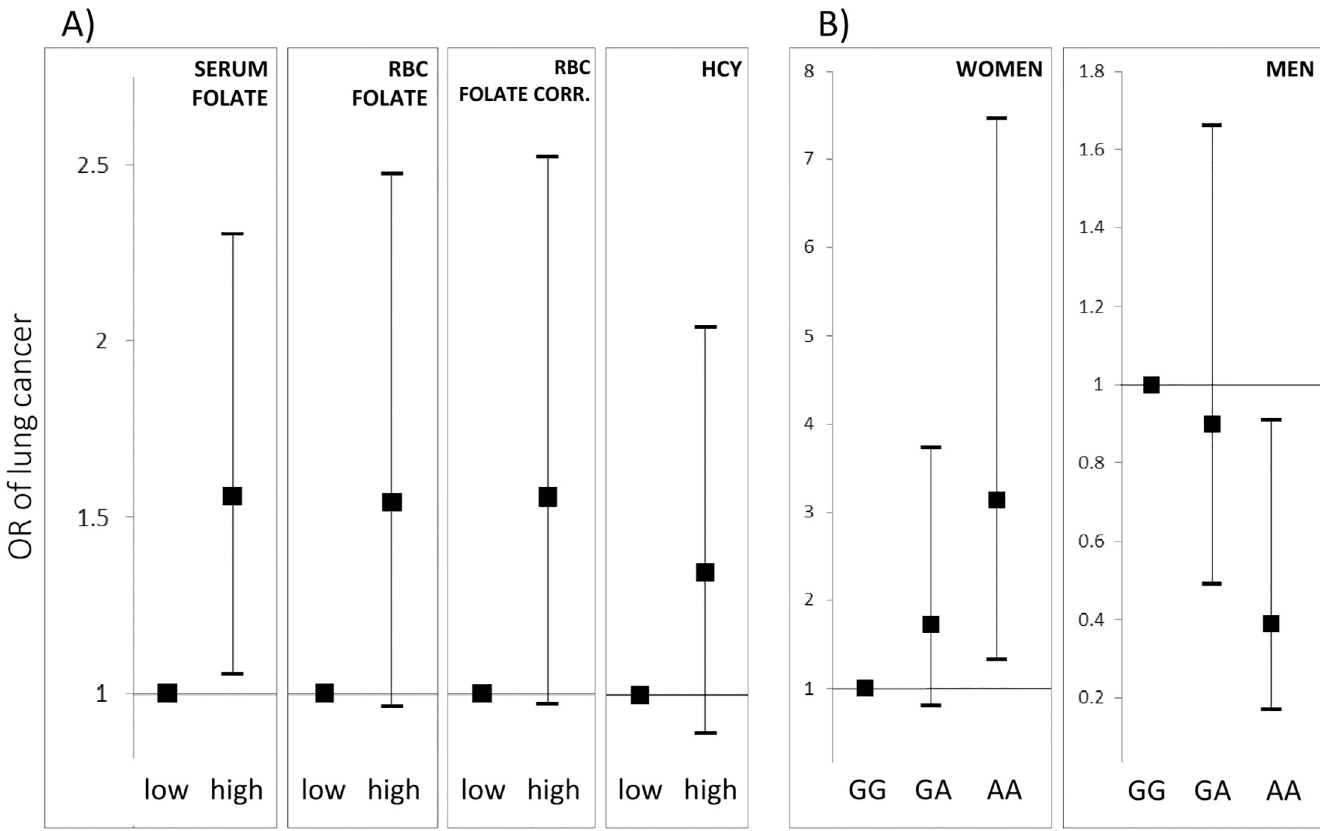
Fig 2. Odds ratios of lung cancer occurrence in relation to A) serum folate, RBC folate, RBC folate corrected and homocysteine levels B) the SLC19A1 c.80A > G genotypes among women and men, in case-control study population from northern Poland.